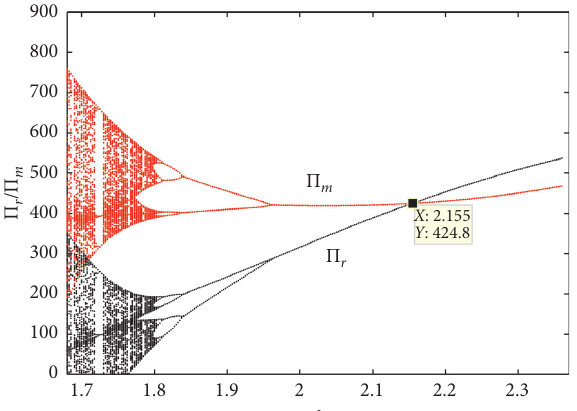
Figure 16: Profits change with s when α